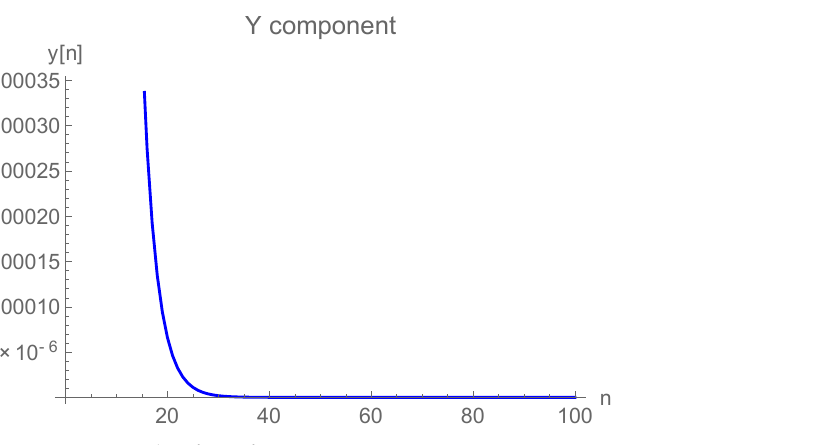
Figure 16. Graph of y n for α = 0.5, β = 1.7, γ = 1.6, δ = 0.3, ζ = 0.7, η = 1.6, µ = 2.7, ε = 0.6, υ = 0.8, ρ = 1.11, σ = 1.11, ω = 0.2. with initial conditions x 0 = 0.002, y 0 = 0.0084 and z 0 = 0.0003.